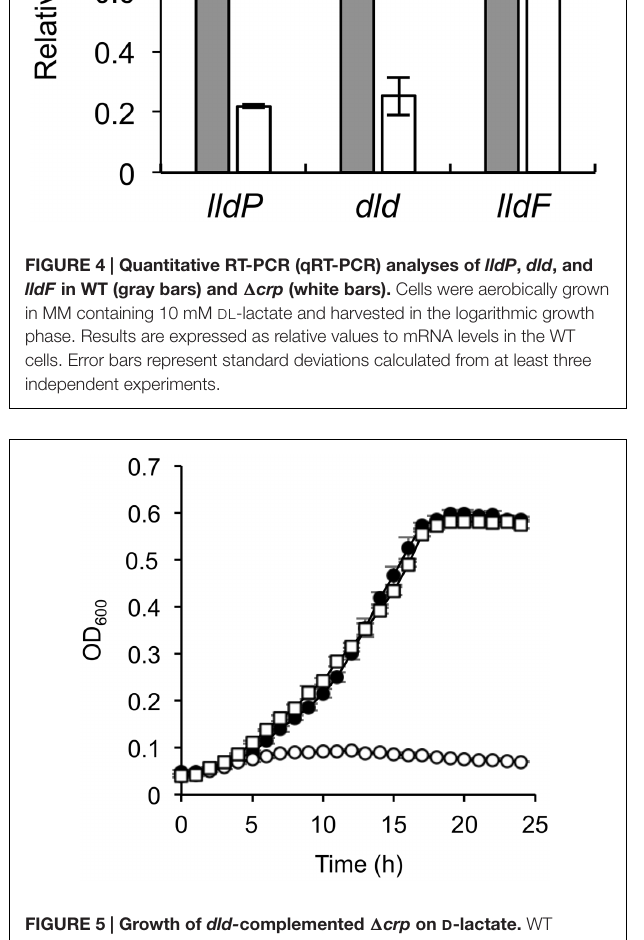
FIGURE 5 | Growth of dld- complemented (cid:49) crp on D -lactate. WT harboring the control vector pBBR1MCS-2 (closed circle), (cid:49) crp harboring pBBR1MCS-2 (open circle), and (cid:49) crp harboring pBBR dld (open squire) were aerobically grown in MM containing 10 mM D -lactate. Error bars represent standard deviations calculated from at least three independent experiments.